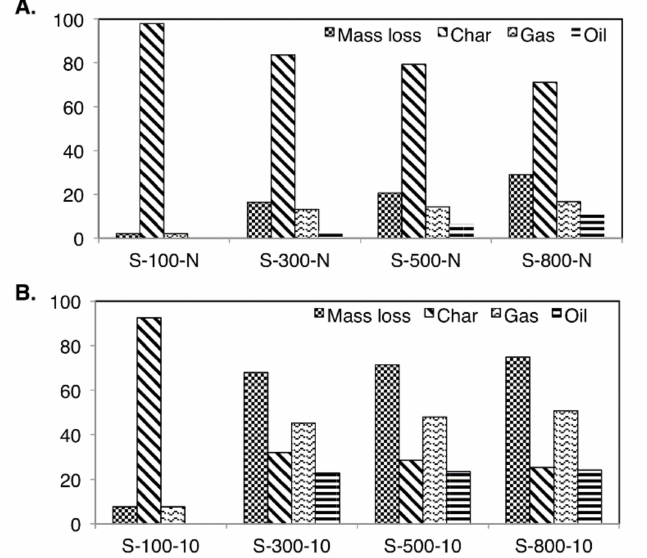
Figure 4. Mass losses and fraction yields of MW-treated samples for the 1st category ( A ) and the 2nd category ( B ). No oil fraction recovery was observed for the samples S-100-N and